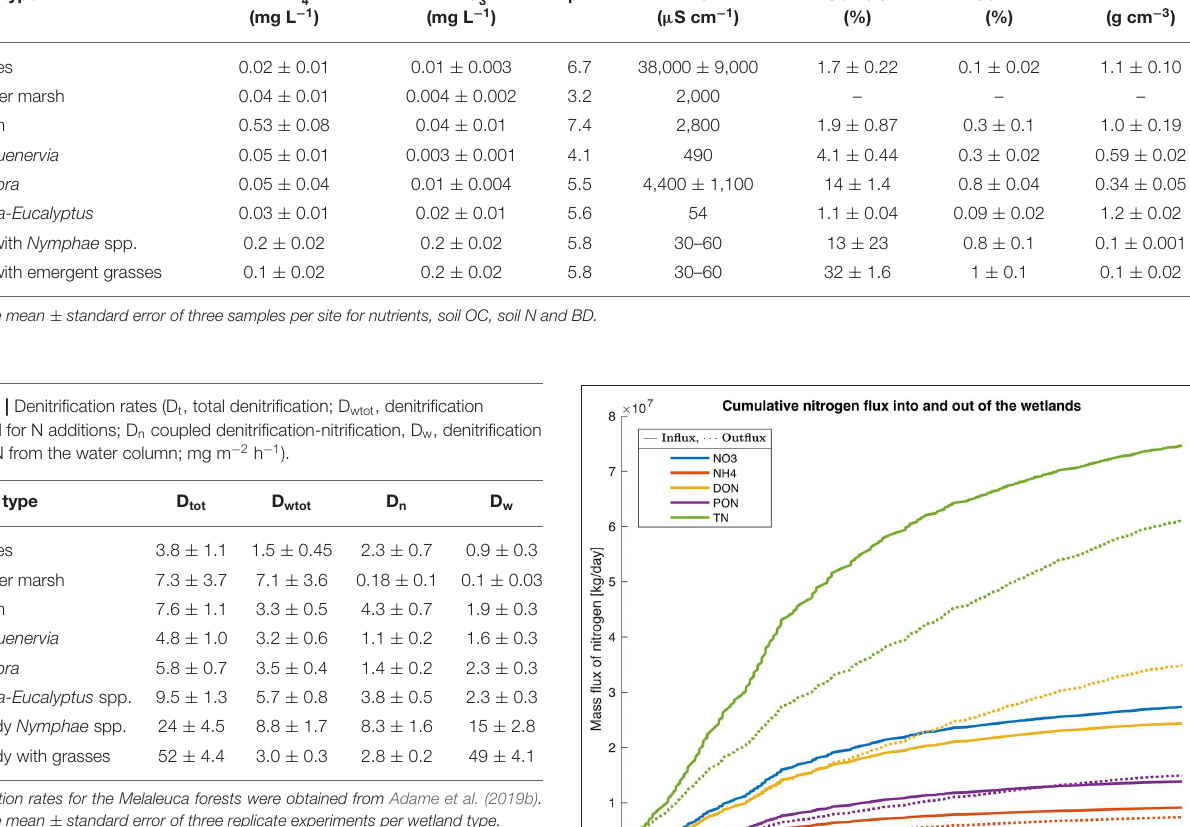
TABLE 2 | Nutrient concentrations in water, pH, electrical conductivity (EC), soil organic carbon (OC), nitrogen (N), and bulk density (BD), from eight coastal wetlands in tropical Australia. Wetland type